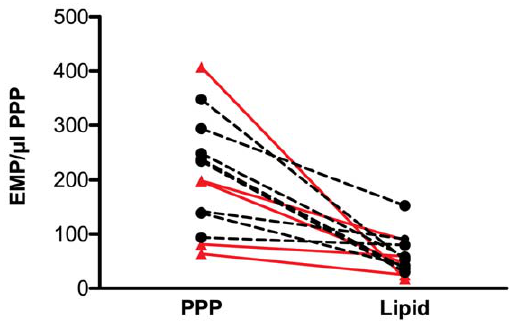
Figure 1. Decrease in EMP after in vitro administration of lipid- rich solutions. Whole blood was taken from 8 healthy volunteers (black) and 5 patients with coronary heart disease (red). PPP was prepared from different aliquots to which lipid-rich solutions were added in different concentrations. EMP were detected by flow cytometry as particles , 1 m m and CD31 + /CD42b 2 . The figure shows EMP numbers/ m l PPP from samples without lipid-rich solutions (PPP), and samples with added lipid-rich solutions in the lowest concentration (Lipid). The number of EMP detected by flow cytometry decreased significantly (all data taken together p=0.001). EMP=endothelial microparticles, PPP=platelet poor plasma.